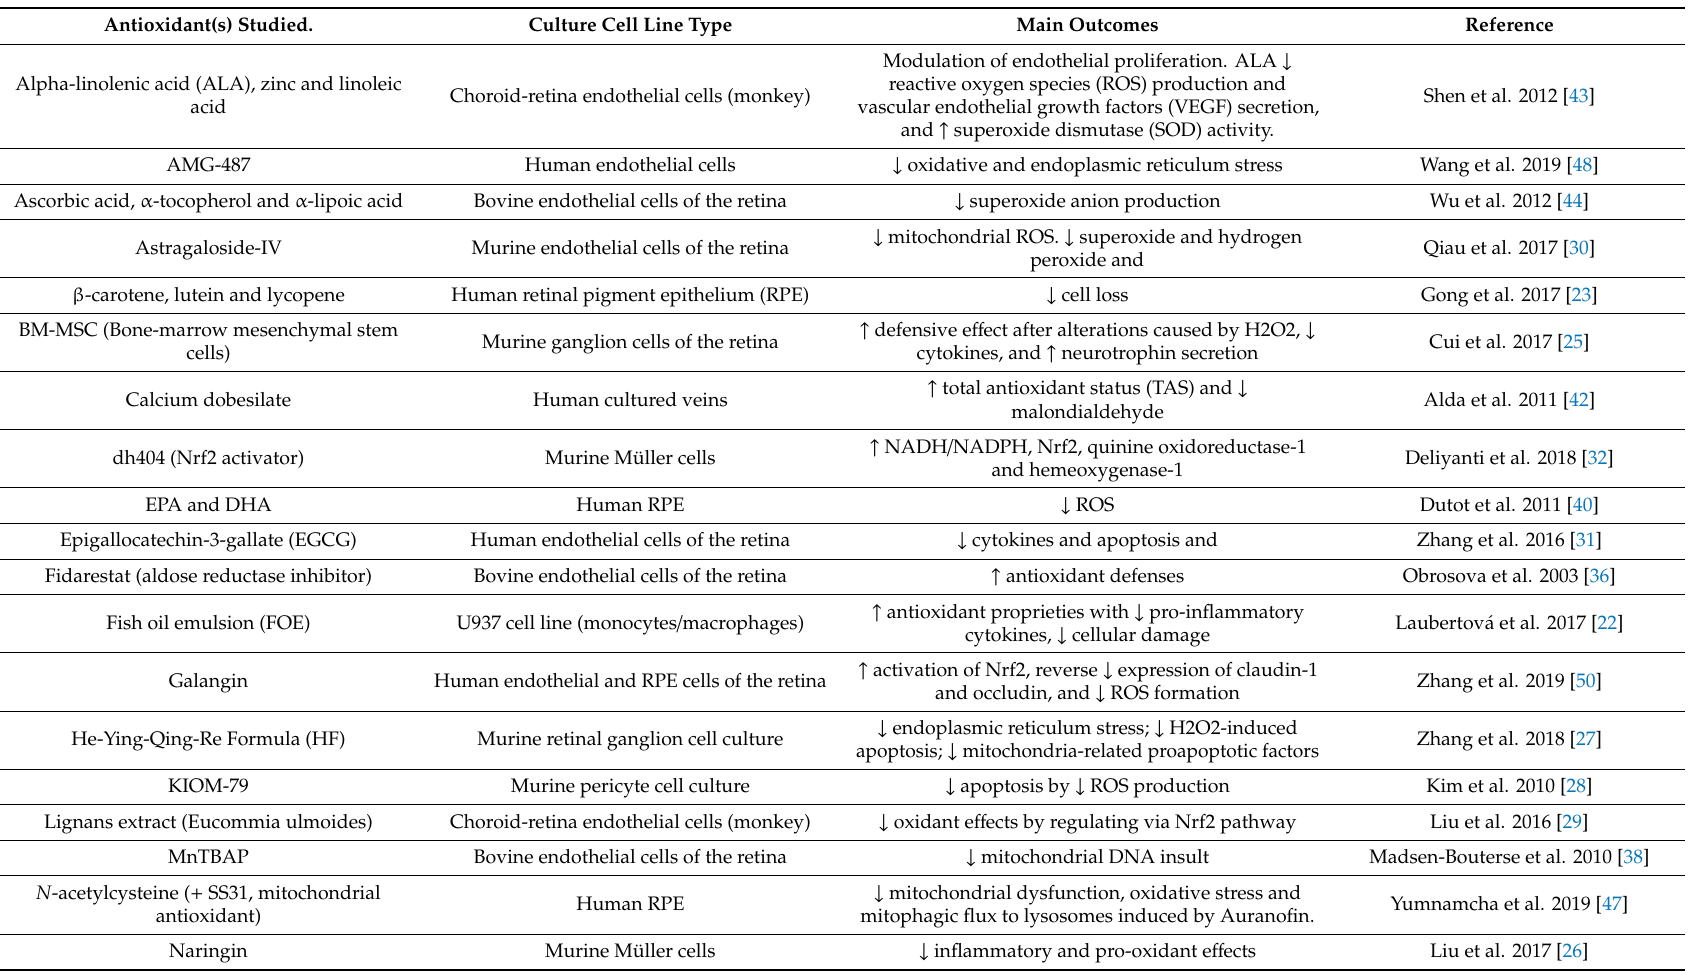
Table 1. In vitro studies on diabetic retinopathy (DR) and hyperglycemic conditions ( ↑ = increase of; ↓ = decrease of). Antioxidant(s)